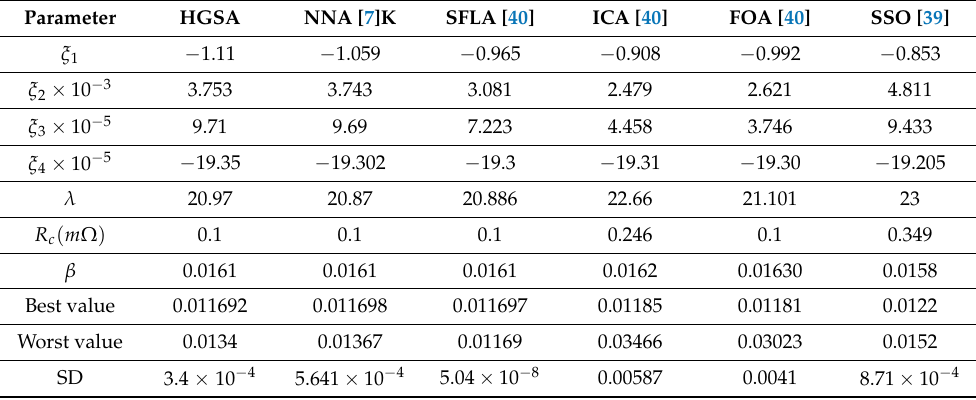
Figure 6. Convergence of the objective function of the BCS PEMFC model. Table 2. Optimal parameters of the BCS PEMFC model.